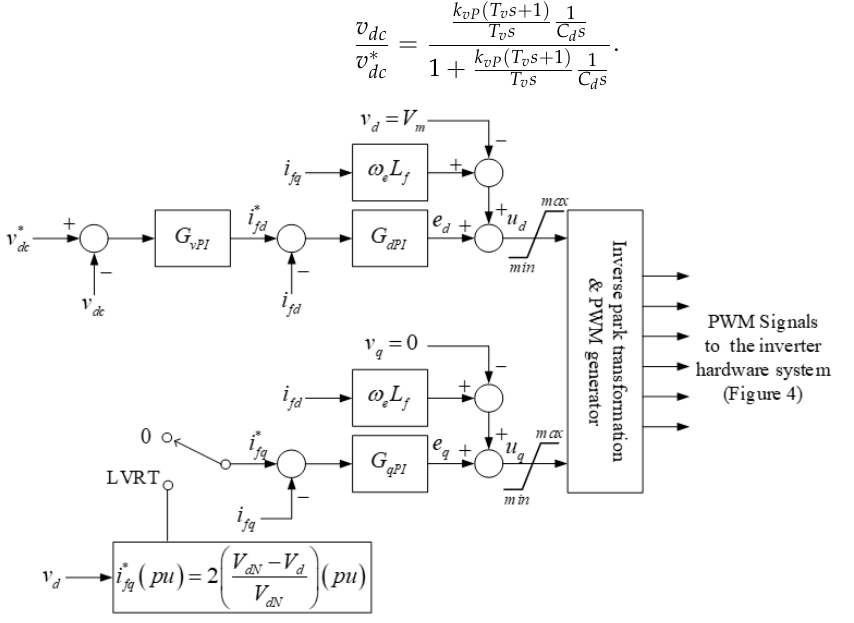
Figure 7. Schematic architecture of the complete LVRTC controller ( ω e denotes the angular frequency of the system).